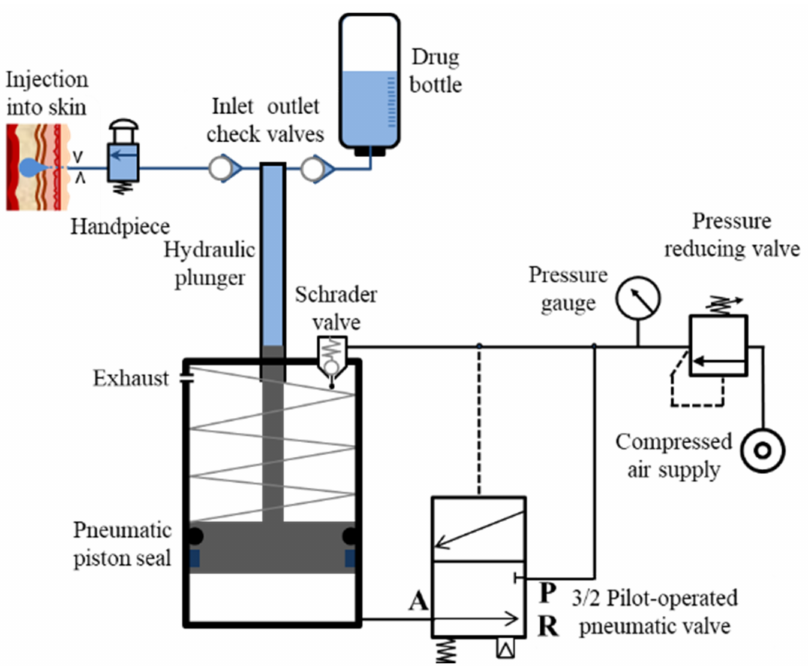
Figure 2. Working mechanism of the developed needle-free jet injection